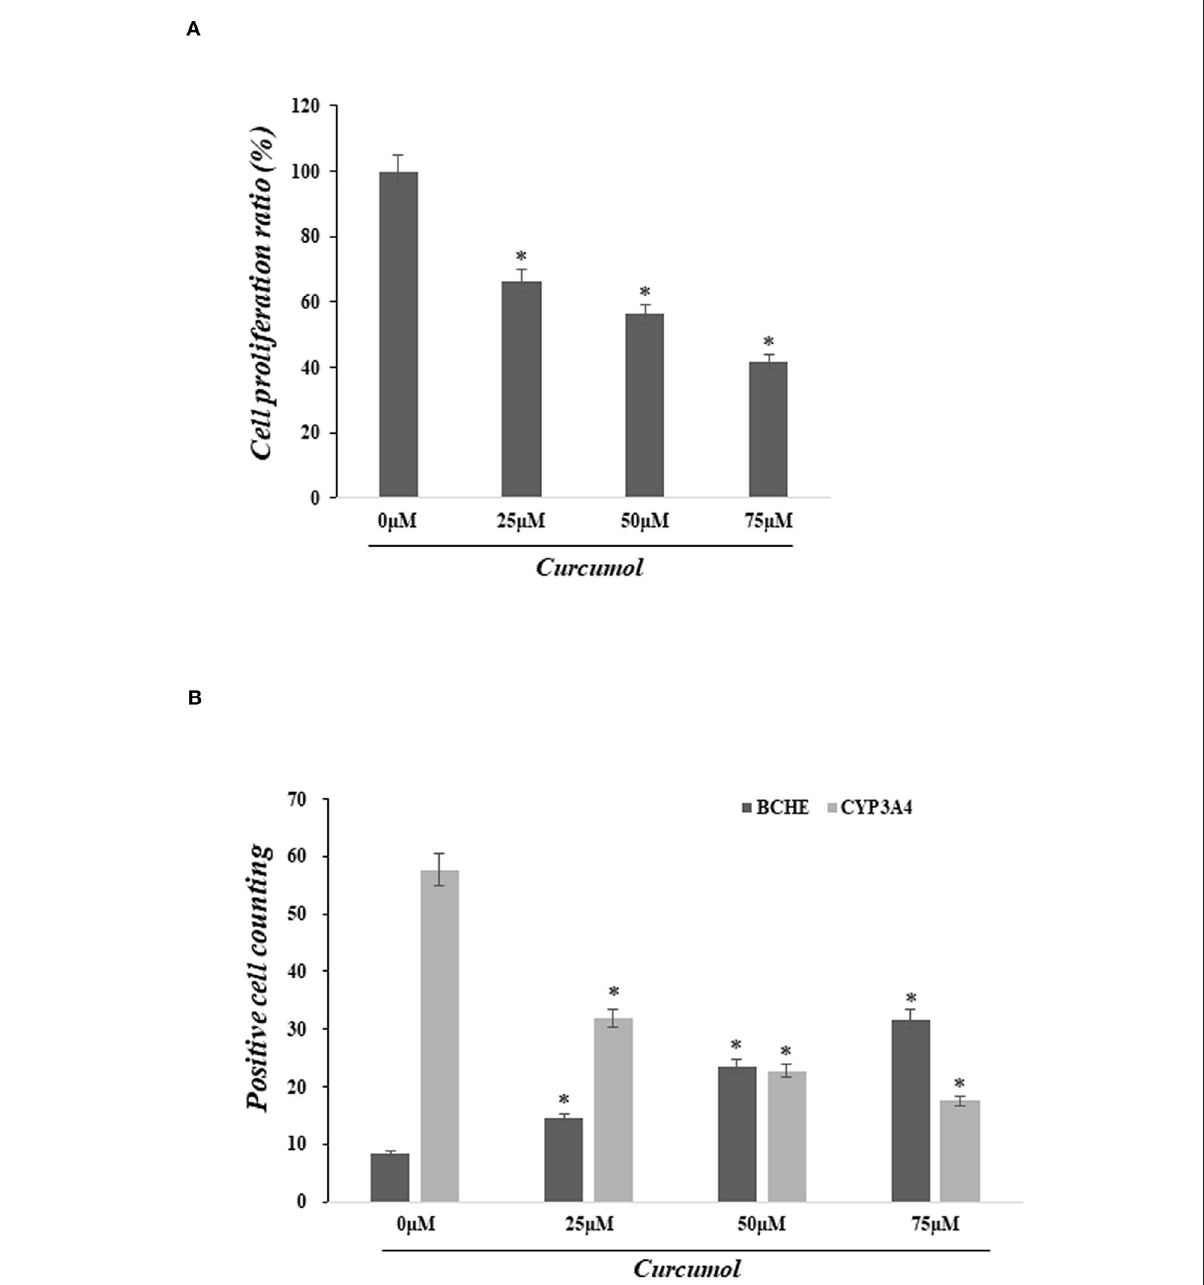
FIGURE4 Curcumol treatment inhibited cell proliferation of colon adenocarcinoma and altered the expression of BCHE and CYP3A4. (A) MTT assay showed significant dose-dependent inhibition of cell proliferation in lung adenocarcinoma cell A594 caused by curcumol treatments (0–75 µ M). (B) Immunofluorescence staining showed that the treatment of curcumol induced the expression of BCHE and reduced the expression of CYP3A4 in COAD cell, as compared to the control group. * p < 0.05.